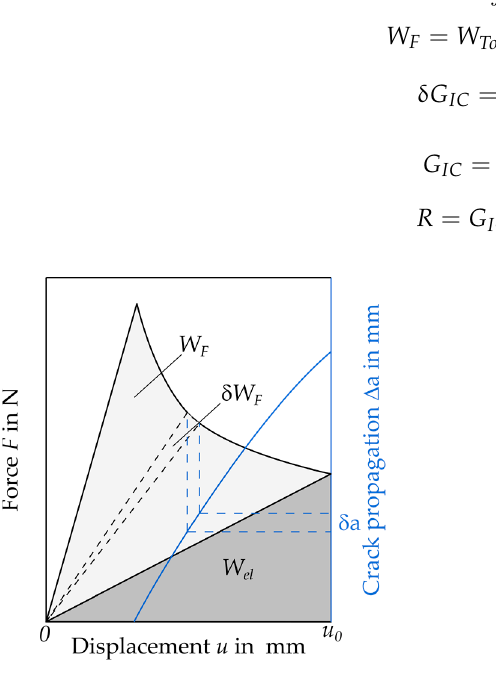
Figure 5. Schematic force-displacement and delamination propagation-displacement curve to de- termine the resistance curves R for mode I